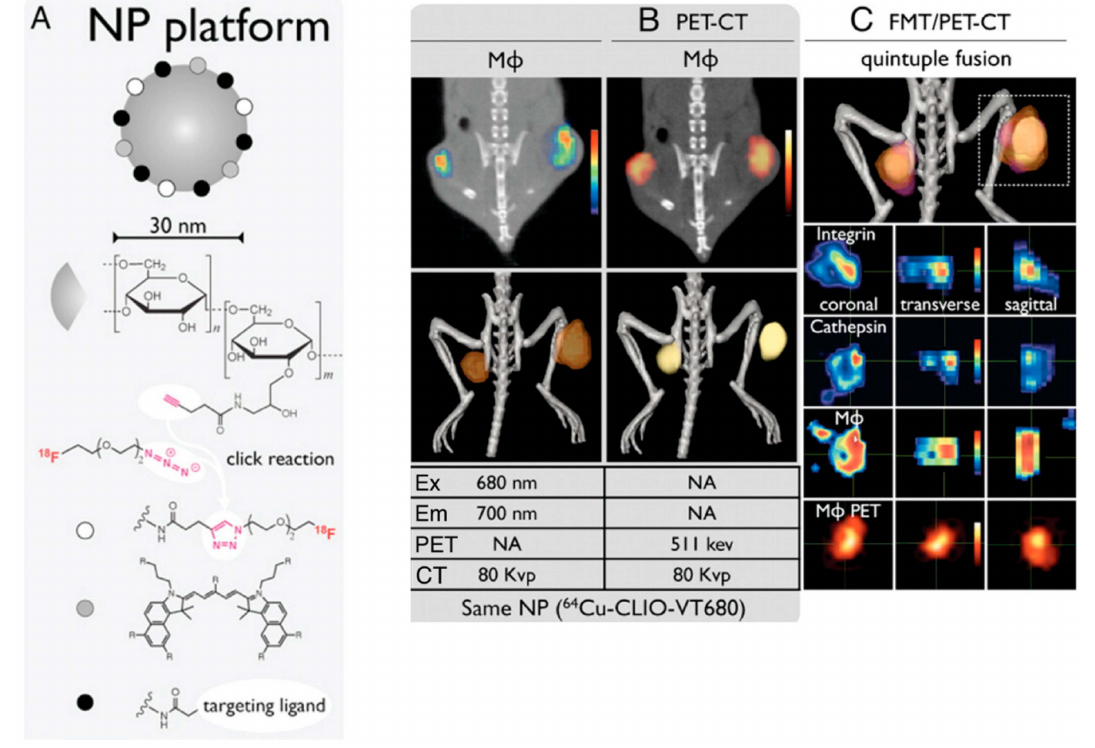
Figure 12. Nanoparticle-based multimodality PET imaging. ( A ) The broad range of targeted ligands that may be conjugated to CLIO, including, but not limited, to 18F through click chemistry and pep- tides. Tumor-bearing mice were coinjected with a fluorescent peptide against integrins, a fluorescent cathepsin sensor, and 64 Cu-CLIO-VT680, and then subjected to in vivo multichannel PET-CT ( B ) and FMT/PET-CT ( C )